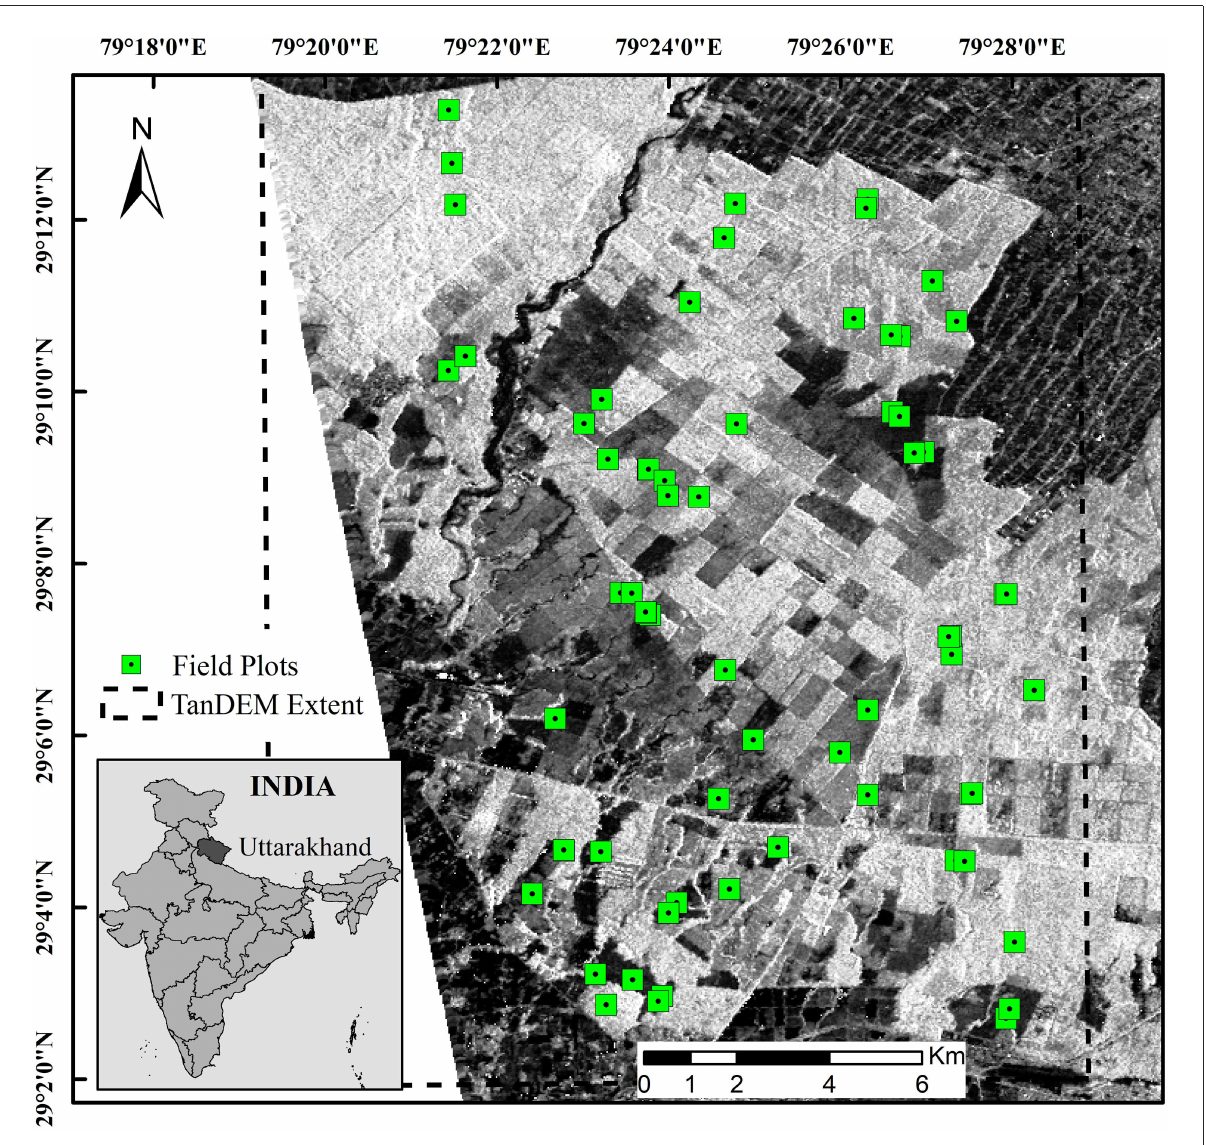
FIGURE1 The ALOS-2/PALSAR-2 HH coherence amplitude image (scaled black for amplitude 0 and white for amplitude 1) of the Haldwani forest range is shown with the location of the field validation plots during field surveys in 2017-18. The extent of the TanDEM-X PolInSAR height is overlaid showing the common overlap region between ALOS-2/PALSAR-2 and